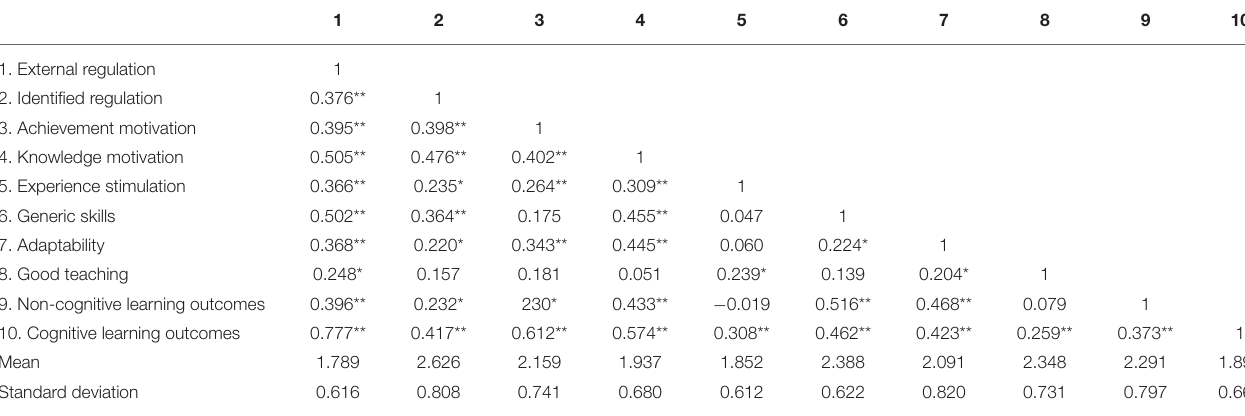
TABLE 3 | Descriptive statistics and correlation coefficients of the